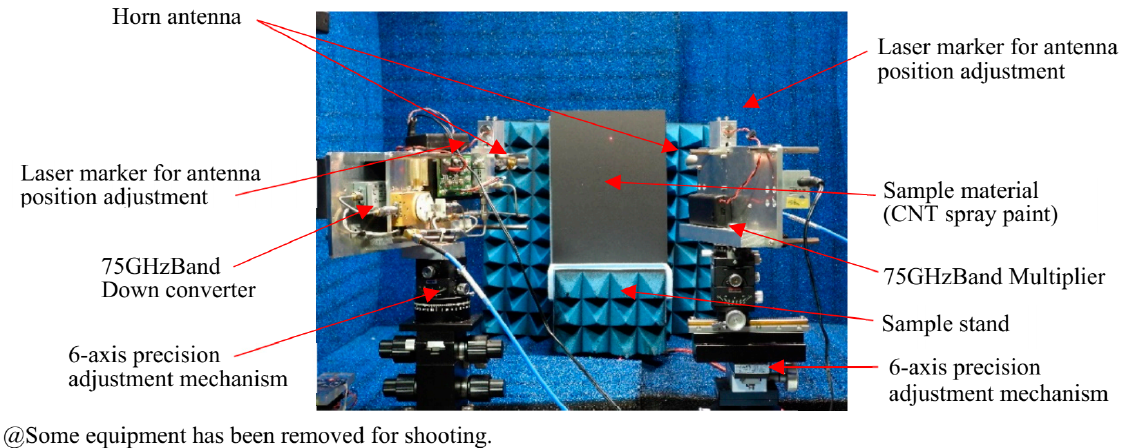
Figure 9. Outline of the installation of the verification system and sample material for 75 GHz